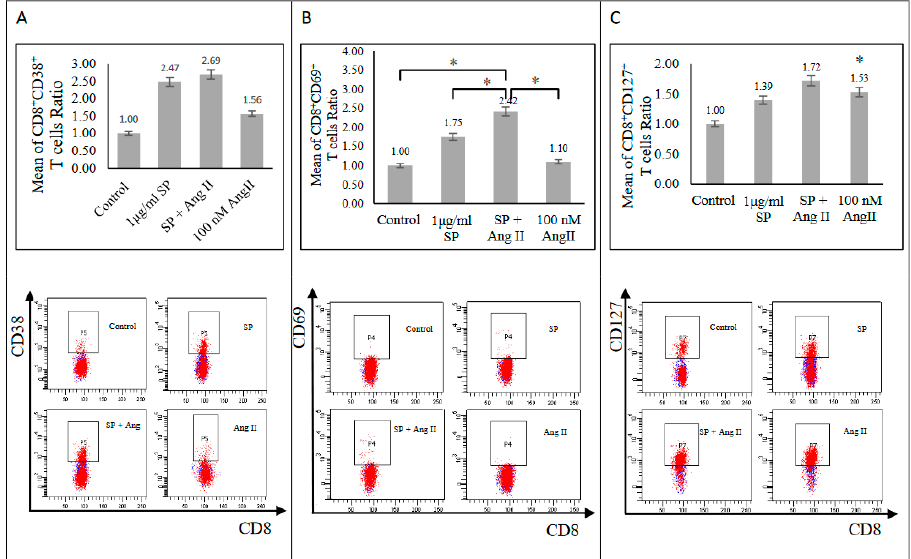
Figure 1. Activated CD8+ T-cells surface markers of recovered COVID-19 patients. ( A ) Upper: CD8+ CD38+ T-cells (n = 8). Lower: FACS representative plot. ( B ) Upper: CD8+ CD69+ T-cells (n = 9). Lower: FACS representative plot. ( C ) Upper: CD8+ CD127+ T-cells (n = 10). Lower: FACS representative plot. The ratio of CD8+ T-cells responses was measured as the mean of the percentage of the cell surface marker-positive T-cells in each group to the percentage of the cell surface marker- positive T-cells in the control group after the stimulation of PBMCs with a SARS-CoV-2 peptide pool (SP), angiotensin II (Ang II), or both of a SP and Ang II. *, p < 0.05.